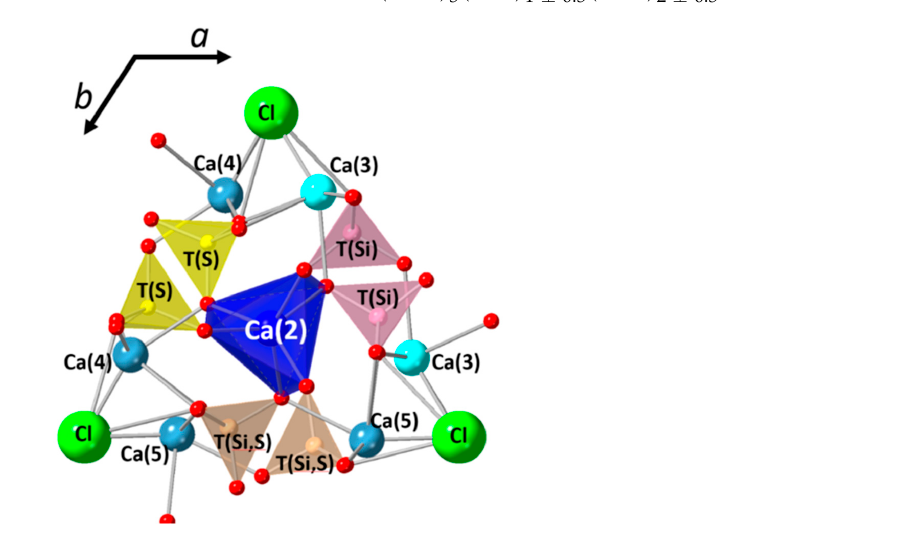
Figure 5. Fragment of the structure of monoclinic Ca 10 (SiO 4 ) 3 (SO 4 ) 3 Cl 2 according to the structure of Ca 9.94 (SiO 4 ) 3 (SO 4 ) 3 (O H) 1.2 O 0.5 Cl 0.32 determined by Organova et al. [19]. T (S) and T (Si,S) tetrahedral sites can partially accommodate CO 3 groups. Ca (3) is the site with Ca deficiency.